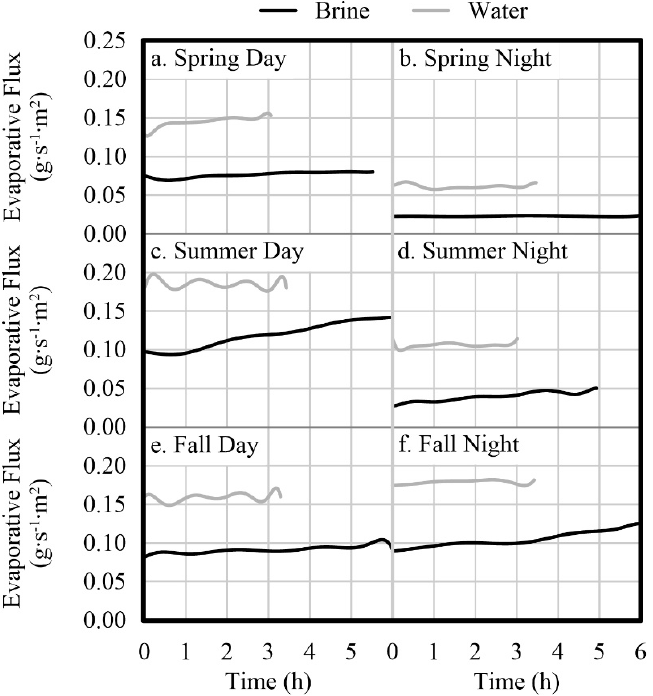
Figure 2. Evaporative flux in the study area for distilled water and saturated brine in ( a ) spring day,